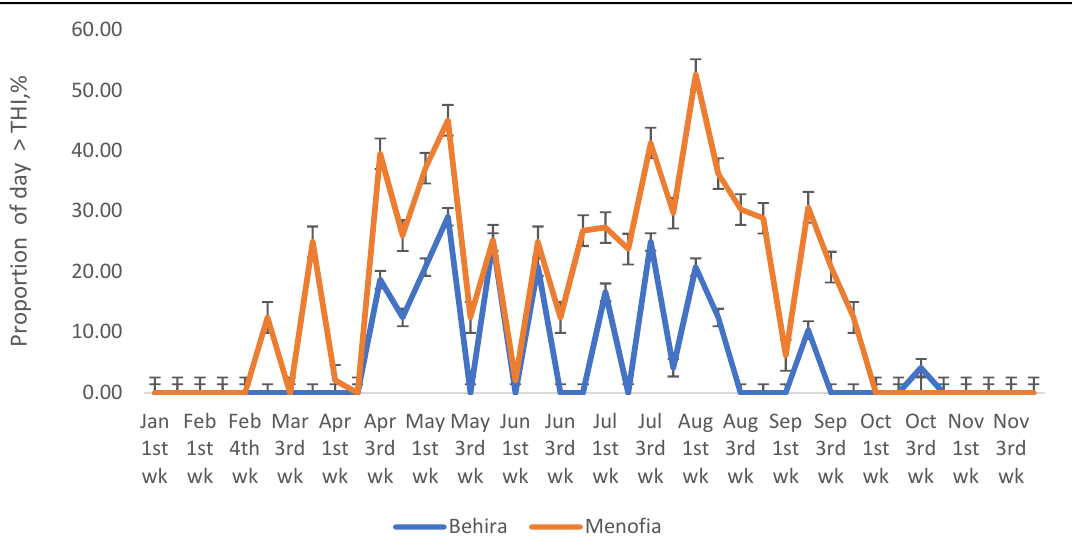
Figure 2. The proportion of half-hour periods in the day that cattle at the two locations (Behira and Menofia) in 2021 experienced THI greater than that believed to cause heat stress.